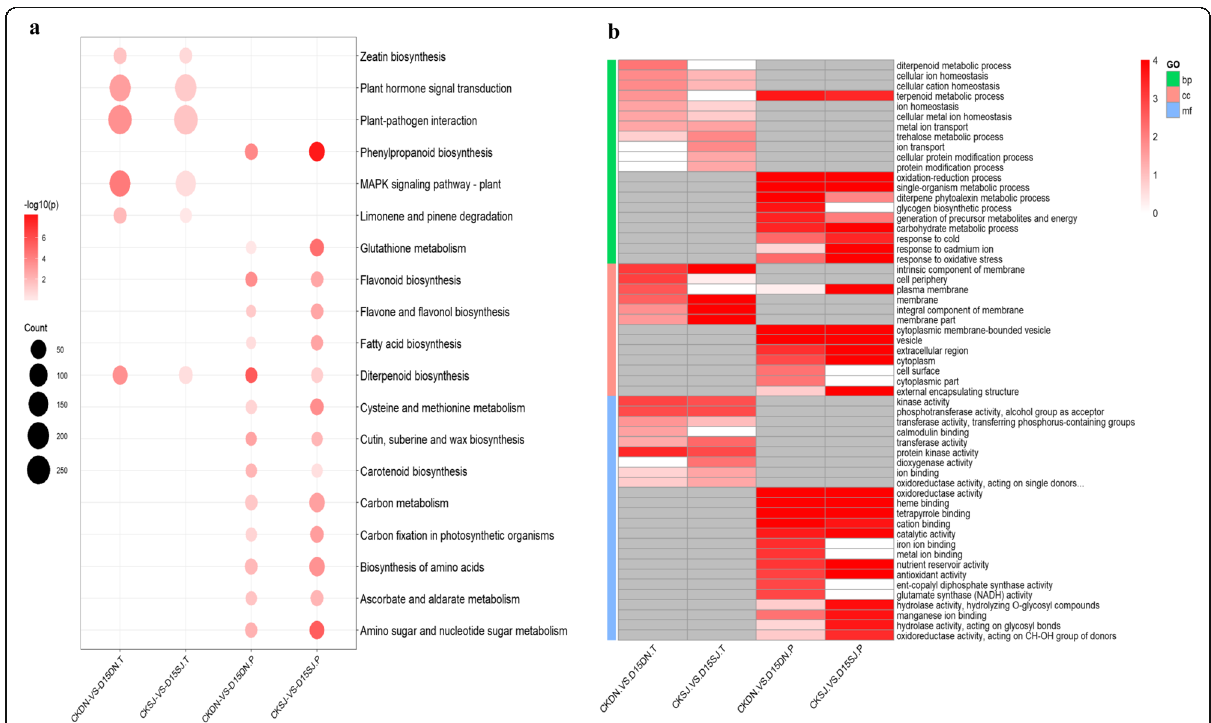
Fig. 3 Enrichment analysis of the cold responsive transcriptome and proteome changes in the two rice cultivars. a, KEGG enrichment analysis of the differentially expressed genes and proteins presented in a bubble chart. b, GO enrichment analysis of the differentially expressed genes and proteins presented as a heat